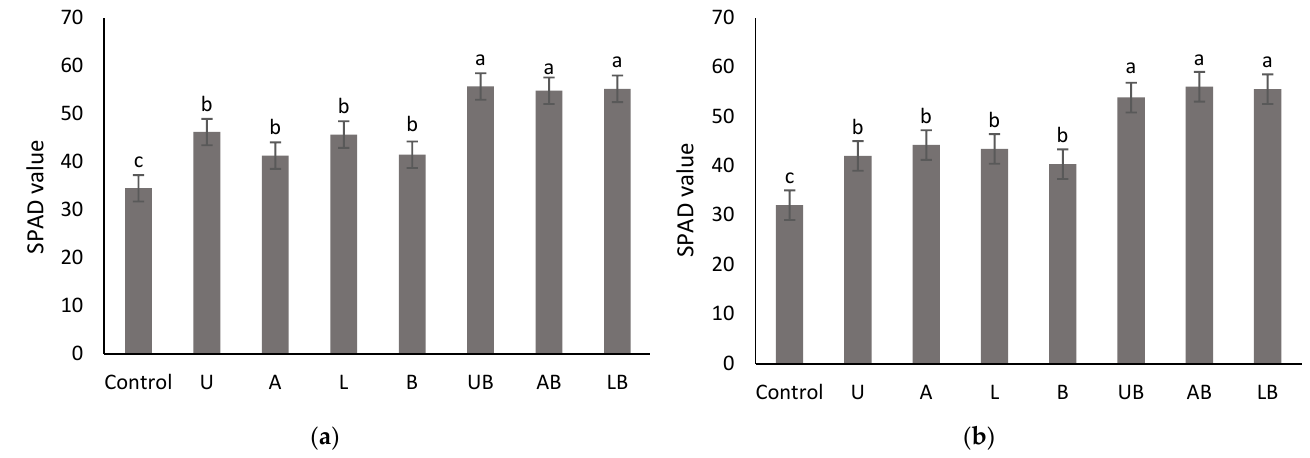
Figure 2. Soil and plant analyzer development (SPAD) values of flag leaves determined during the ( a ) jointing stage and ( b ) grain filling stage of wheat plants in soil treated with different N-fertilizers and biochar. Significant differences of means are shown by different lowercase letters. Table 3. Nitrogen supply, yields and nitrogen yields as affected by treatments and N supply.